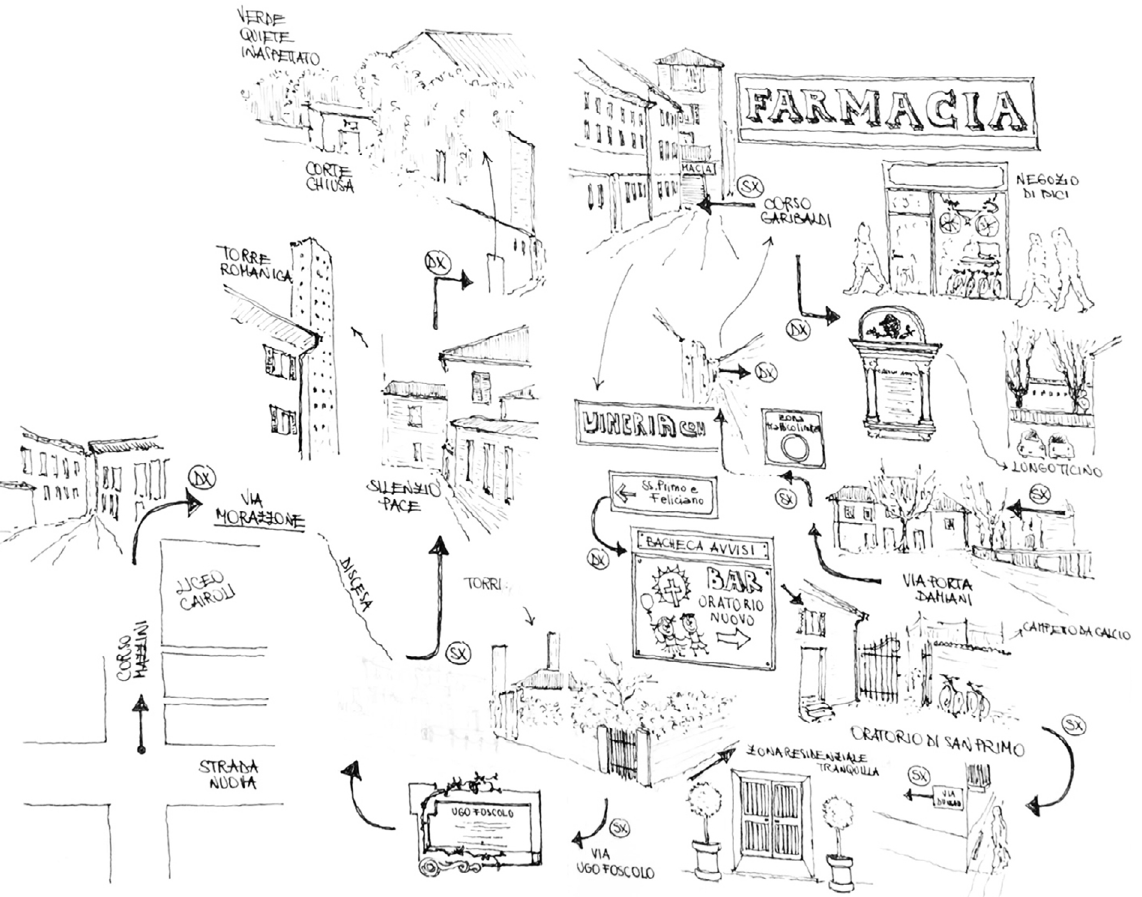
Various sketches of buildings and urban spaces, as composed during a dérive walk (image by Anita Beluffi, Maddalena Duse, Linda Migliavacca, Michela Rib-